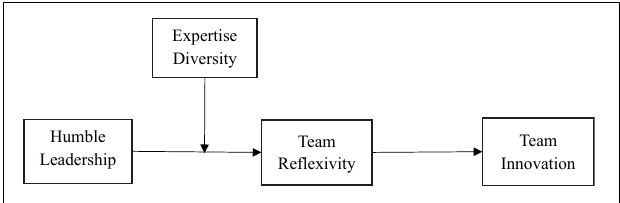
FIGURE 1 | Hypothesized direct and indirect relationship in this